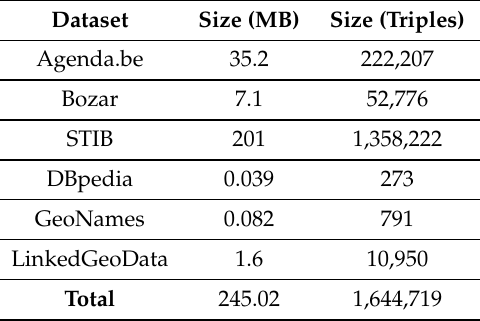
Table 8. Size of the datasets in the